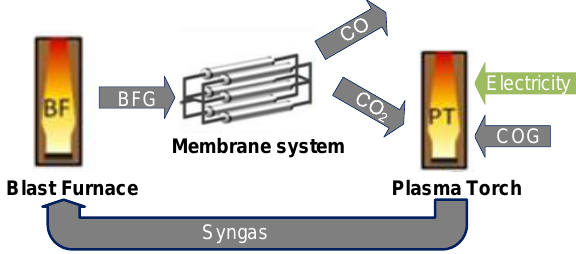
Figure 1. Concept considered in the study.